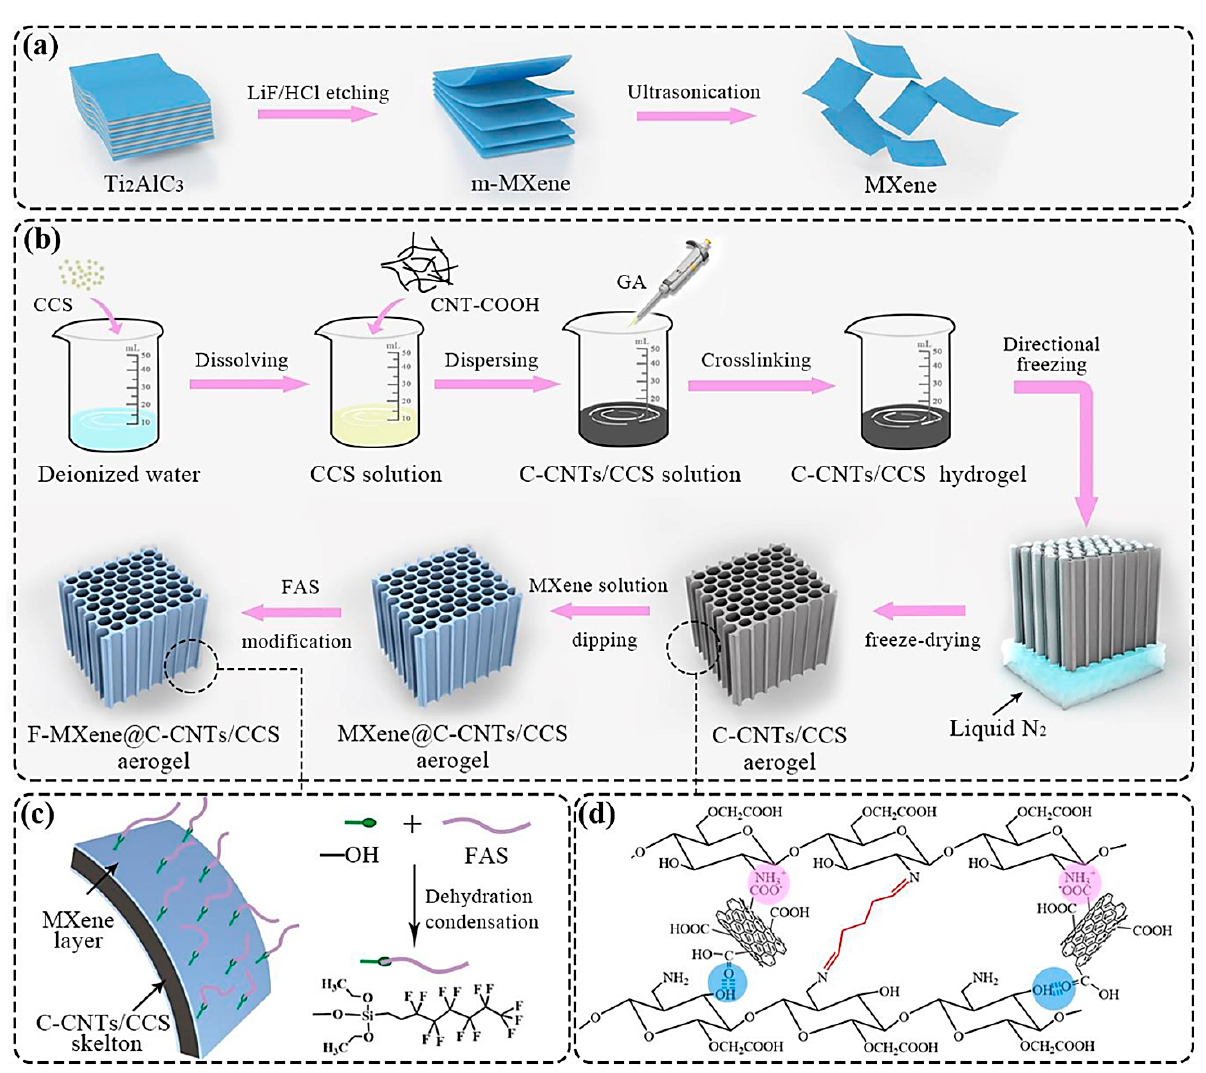
Figure 4. ( a , b ) The preparative process of MXene (Ti 3 C 2 T x ) nanosheets and an MXene-coated car- boxylated (C)-CNTs/carboxymethyl chitosan (CCS) composite aerogel. ( c ) The chemical modification of MXene layers by 1H,1H,2H,2H-perfluorooctyltriethoxysilane (FAS). ( d ) The generation of imine bonds between the amino groups of CCS and the aldehyde groups of glutaraldehyde (GA) as cross-linkers with related interactions between carboxylated CNTs and CCS. Adapted from Ref [90] with permission. Copyright 2021 Elsevier.